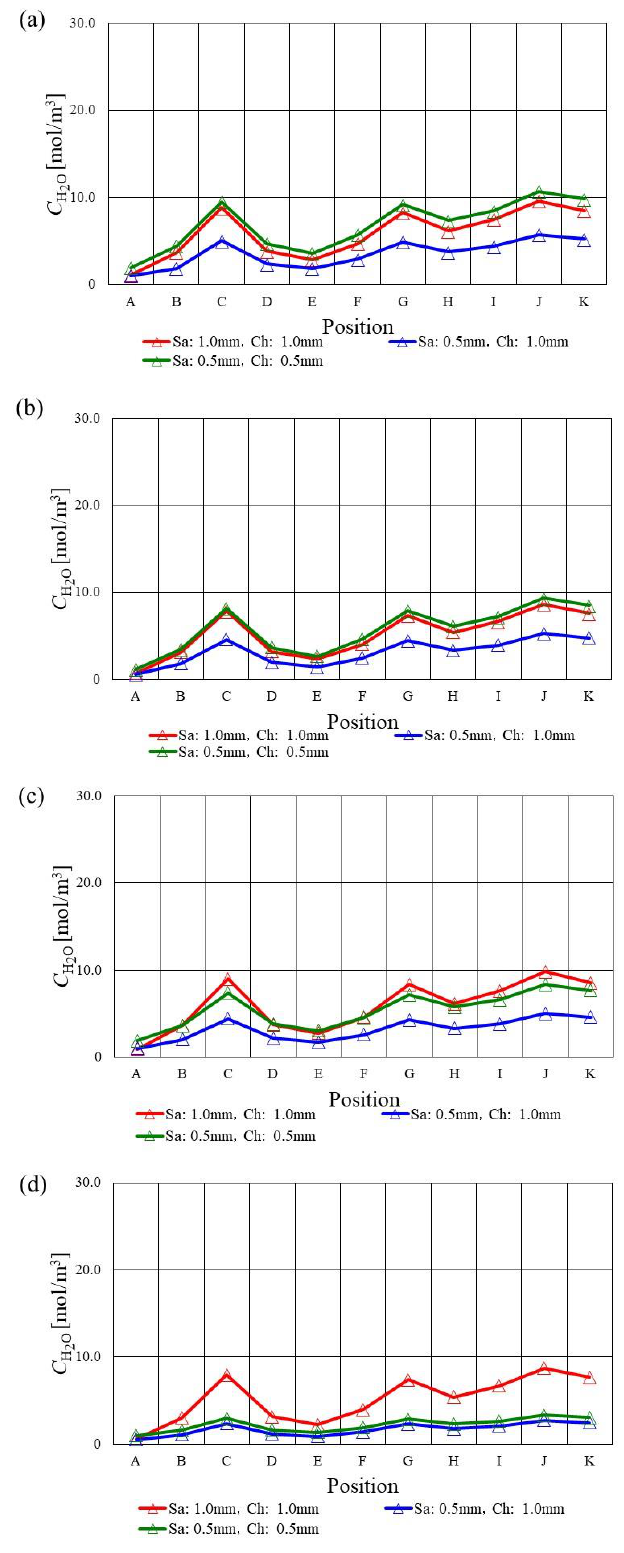
Figure 9. Molar concentration of H 2 O along with the gas channel on the interface between PEM and catalyst layer at the cathode among various s.t. at T ini = 363 K. ( a ) A80%RH/C80%RH, ( b )